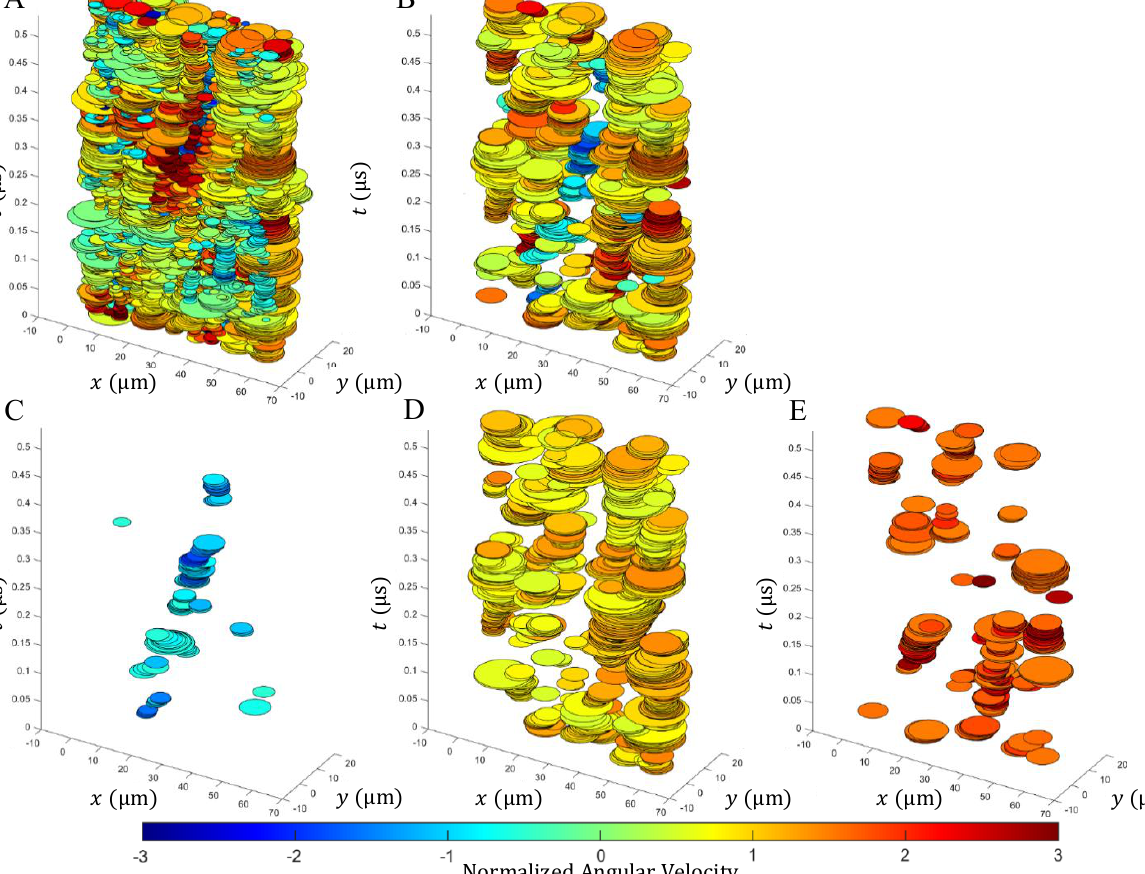
Fig. 5. A. Stacked representation of all detected vortices during a 0.5 µs period of shearing, represented as discs with the correct (𝑥, 𝑦, 𝑅) properties (time is on the vertical axis) and color-coded by normalized angular velocity; B. Vortices of A filtered based on coherence (larger than 0.4 or smaller than −0.4 ); C. Vortices of B filtered based on normalized angular velocity (lower than 0.5 ); D. Vortices of B filtered based on normalized angular velocity (between 5 and 1.5 ); E. Vortices of B filtered based on normalized angular velocity (larger than 1.5